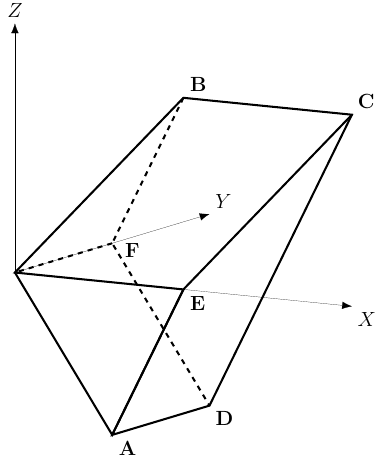
Figure 2. The sticking region of the system, defined as the subset of the state space XYZ in which both asperities are at rest: a convex hexahedron H (α = 1 ,β = 1 )